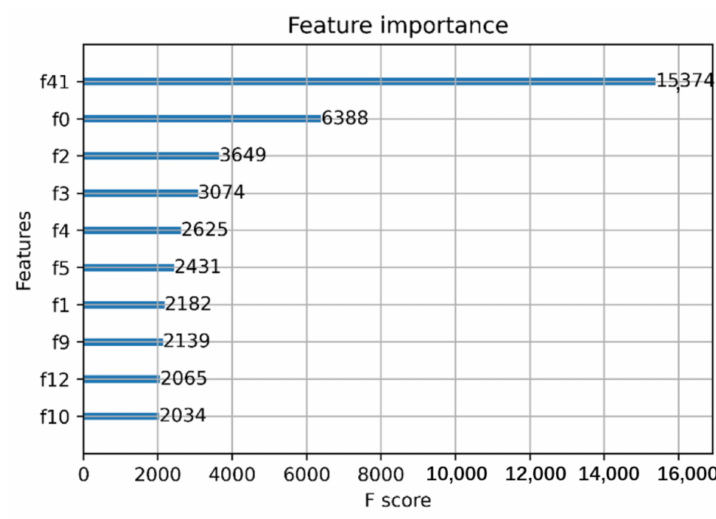
Figure 4. Feature importance ranking and weight